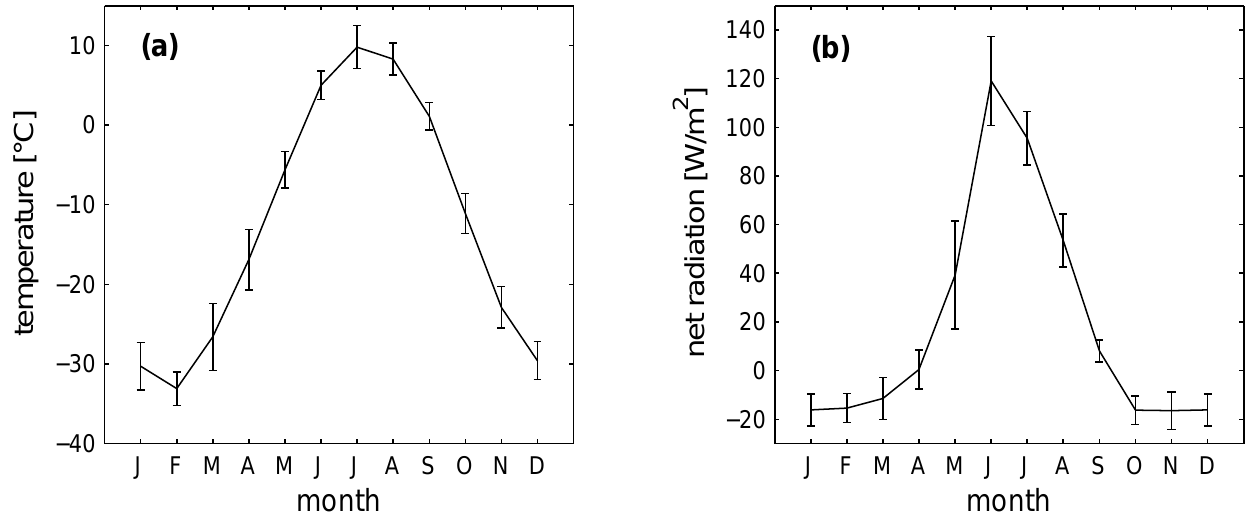
Fig. 7. Air temperature (a) , and net radiation (b) , measured on Samoylov Island from 1998–2011. The bars are standard deviations of the monthly